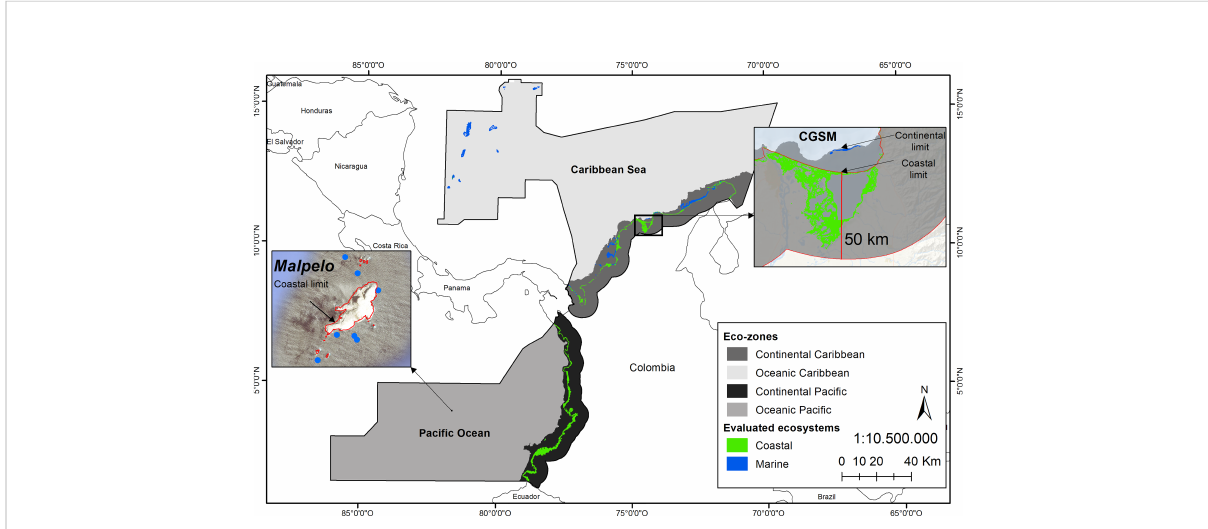
FIGURE 1 Study area. This map shows the four ecozones and the location of the evaluated coastal and marine ecosystems, including the mangrove coastal area of the Cie ́ naga Grande of Santa Marta and the marine ecosystem locations of Malpelo Island. The coastal limit (red line) encloses coastal environments, and the continental limit (200 m isobath) encloses continental